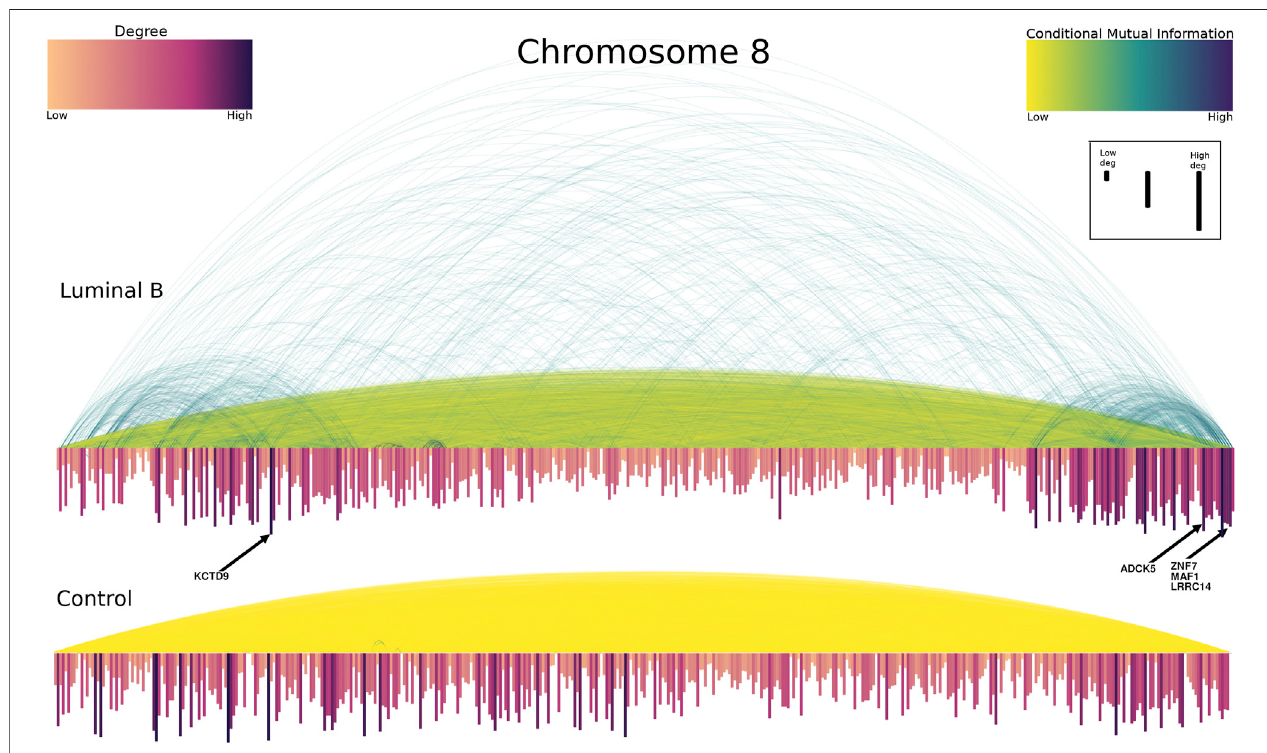
FIGURE6 | Top CMI values between genesof Chromosome 8for LuminalB (upper) and control (lower) networks. In this fi gure, the genes areplaced according to itsstartposition.Yellow-to-bluearcsrepresentco-expressioninteractionsbetweentheconnectinggenes.Thesizeandcolorofthegenesareproportionaltothedegree. Asitcanbeobserved,forthecaseofLuminalB,theextremeleftandrightsidescontainthemajorityofhighestCMIinteractions(darkarcs),inparticular,cytobandsq24.3 and p11.21 – 23. Conversely, in the control network, interactions are not particularly biased to a speci fi c region. Top-degree genes are indicated with black arrows. ZNF7, MAF1 and LRRC14 genes are overlapped in the fi gure.